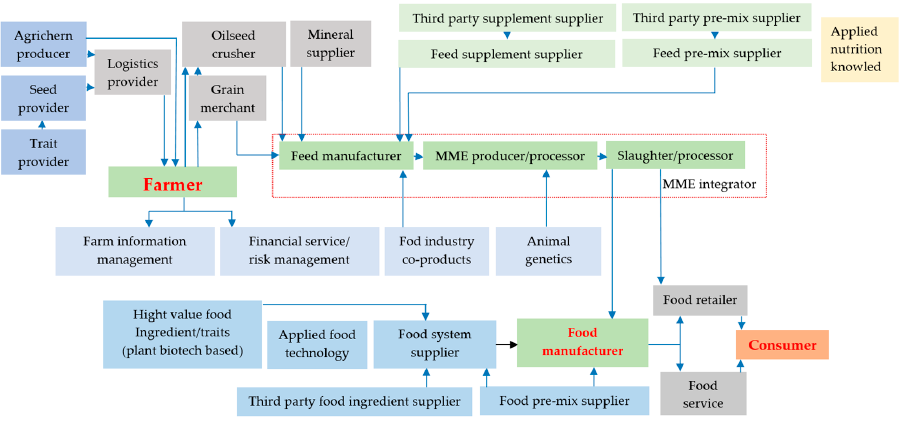
Figure 5. Total food supply chain (Source: Bruno Walter Castro-Karney